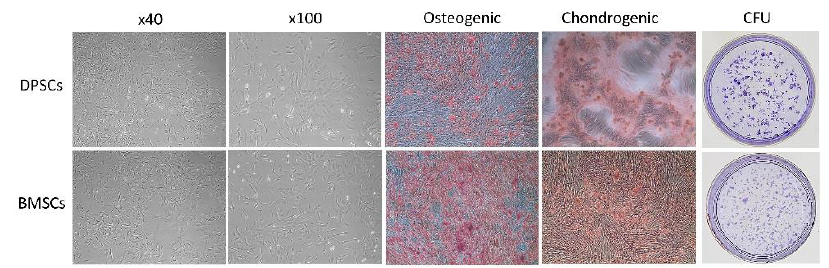
Figure 2. Characteristics of both the DPSCs and BMSCs.